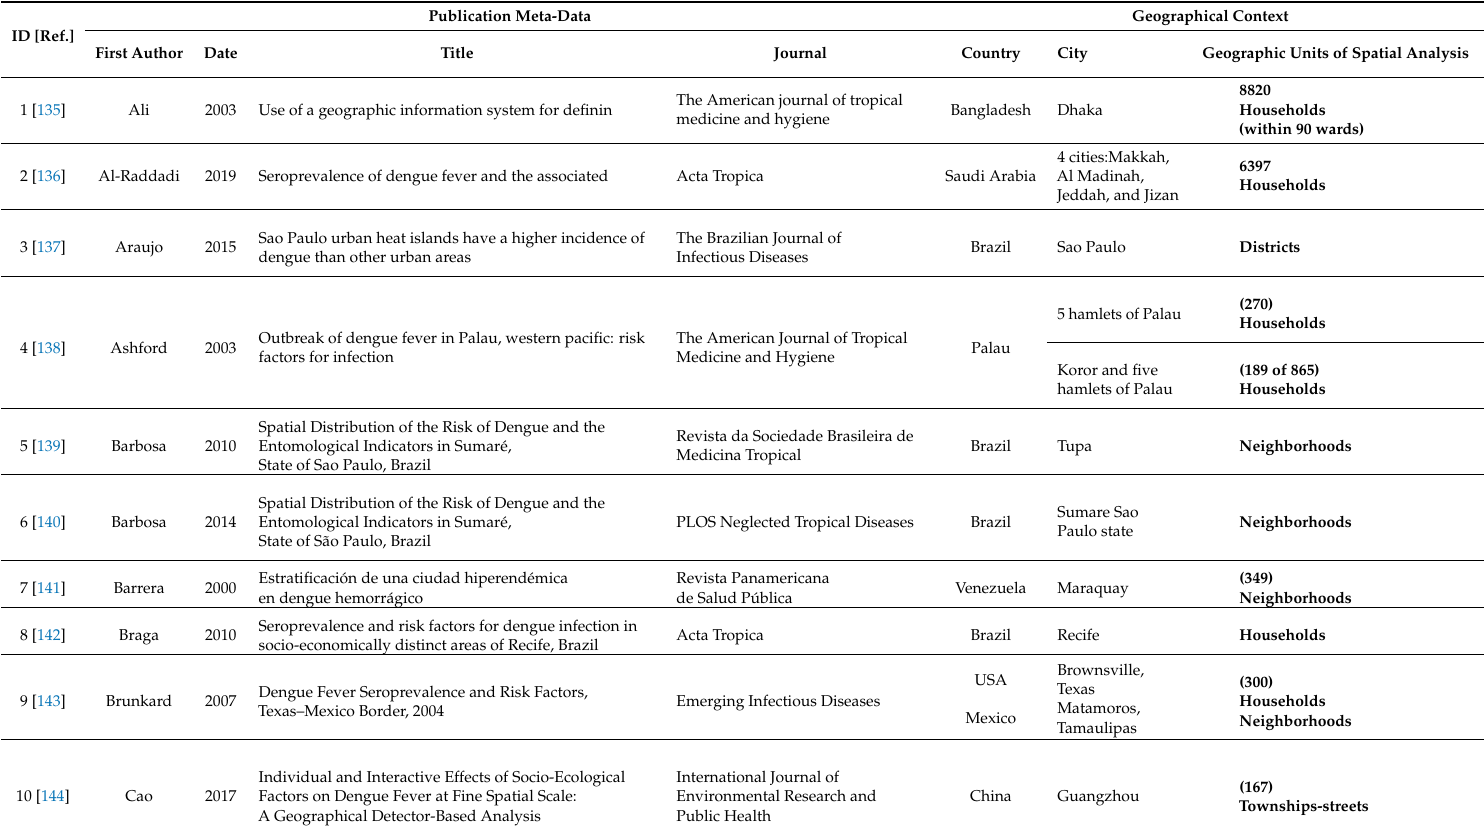
Table A1. Extraction of the publication meta-data (first author, date of publication, title, name of the journal), and description of the geographical contexts (country, city, geographical unit) of the 78 included